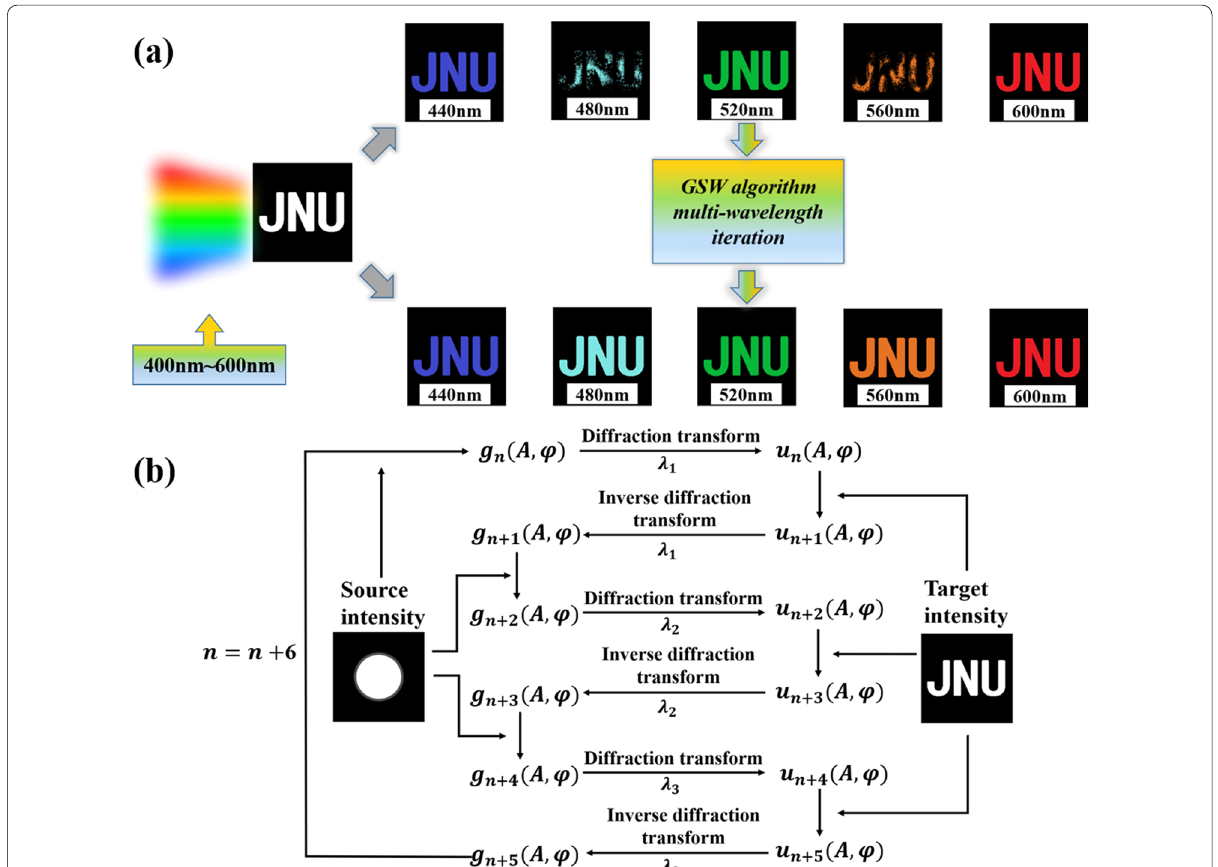
Fig. 4 a The effect diagrams of “JNU” color hologram imaging are achieved by single‑wavelength iteration algorithm (upper row) to multiwavelength iteration algorithm (lower row). b Multiwavelength iterative algorithm process for wide‑band